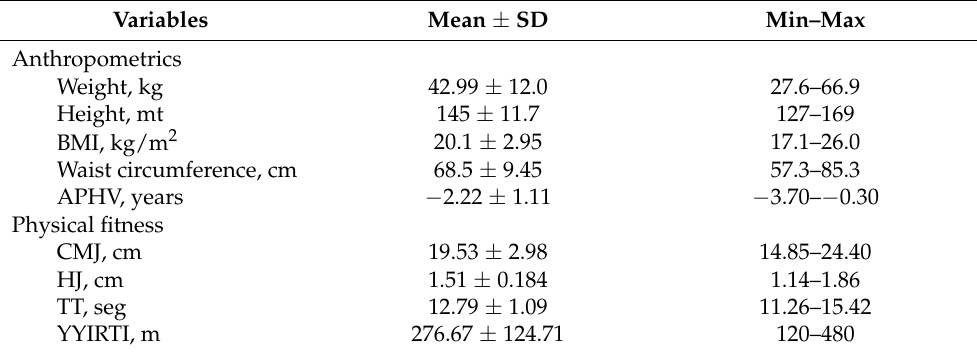
Table 1. Characteristics of the